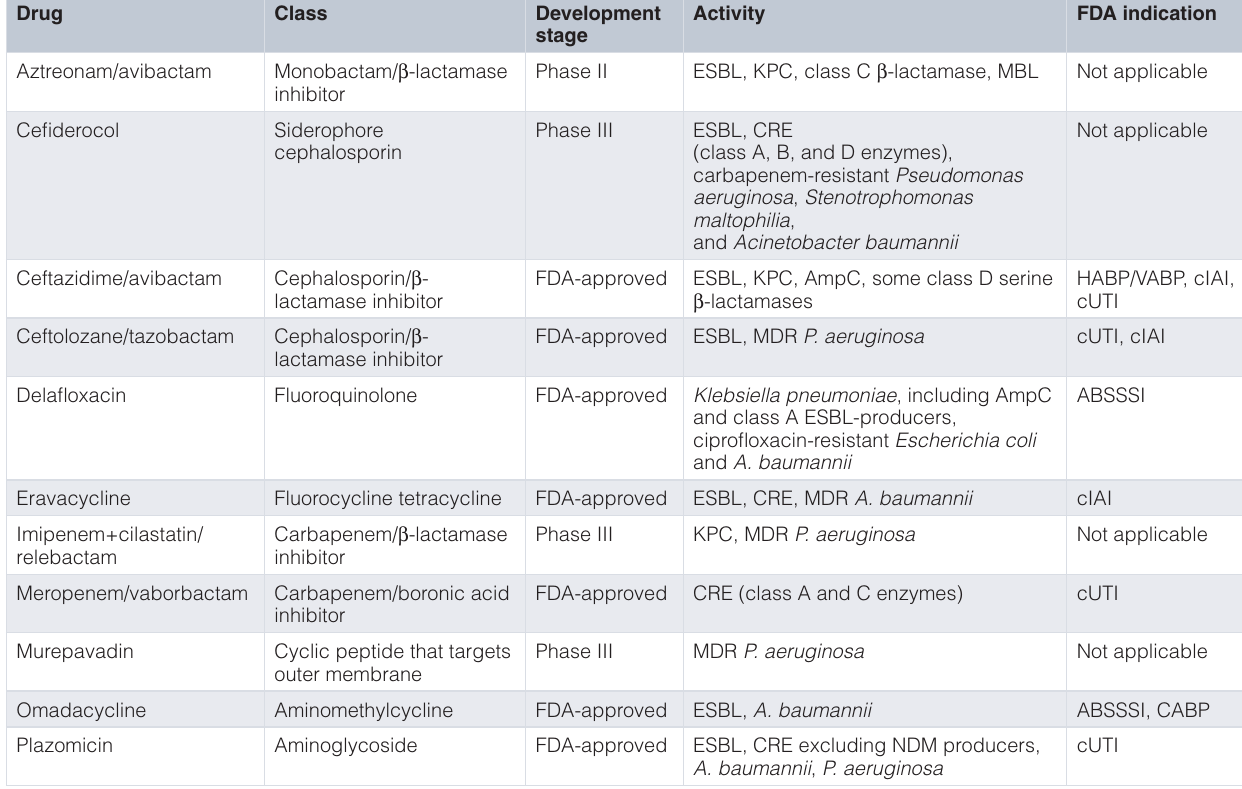
Table 1. New antibiotics for multidrug-resistant Gram-negative bacteria.